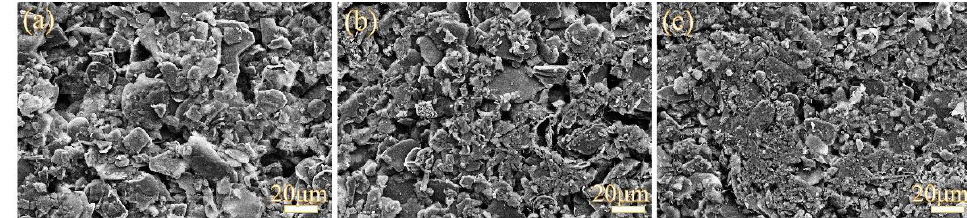
Figure 4. SEM micrograph of seals after being heated to 750 °C under 0.1 MPa ( a ), 0.2 MPa ( b ), and 0.3 MPa ( c ).